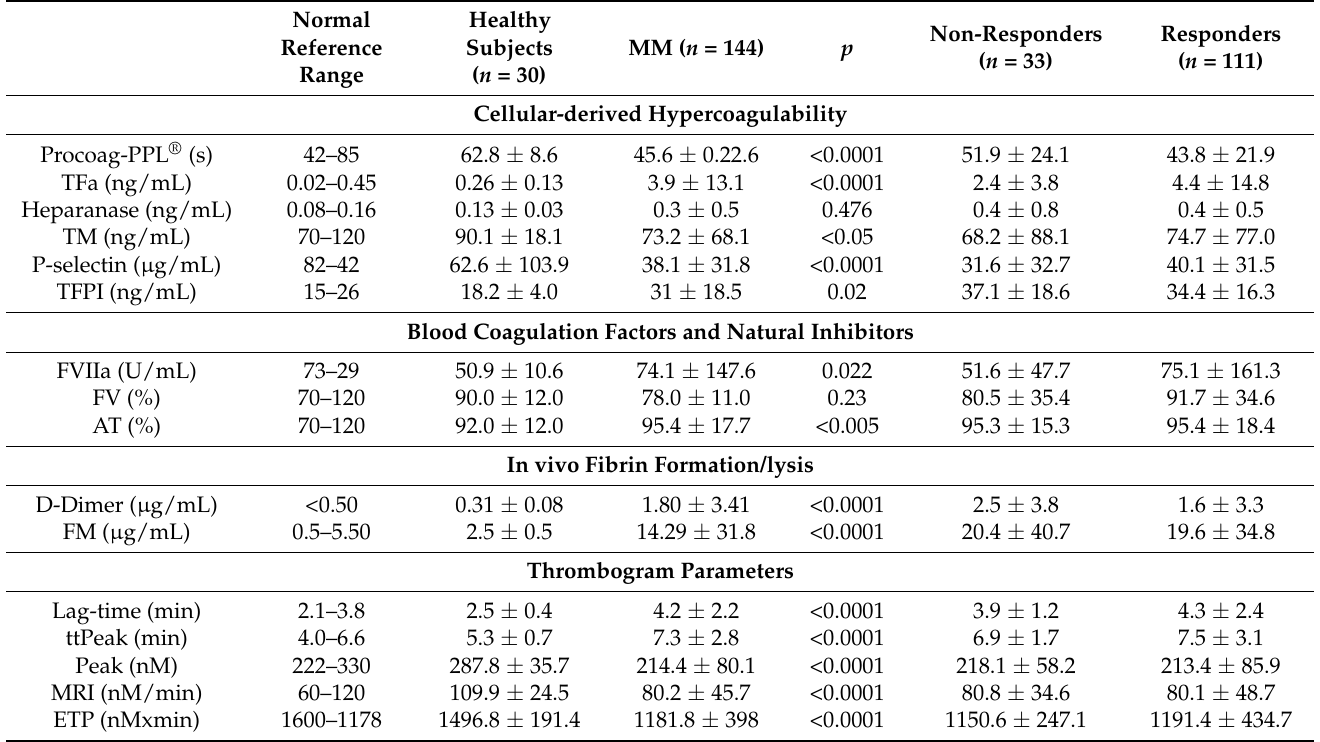
Table 2. Profile of hypercoagulability in NDMM patients prior to treatment